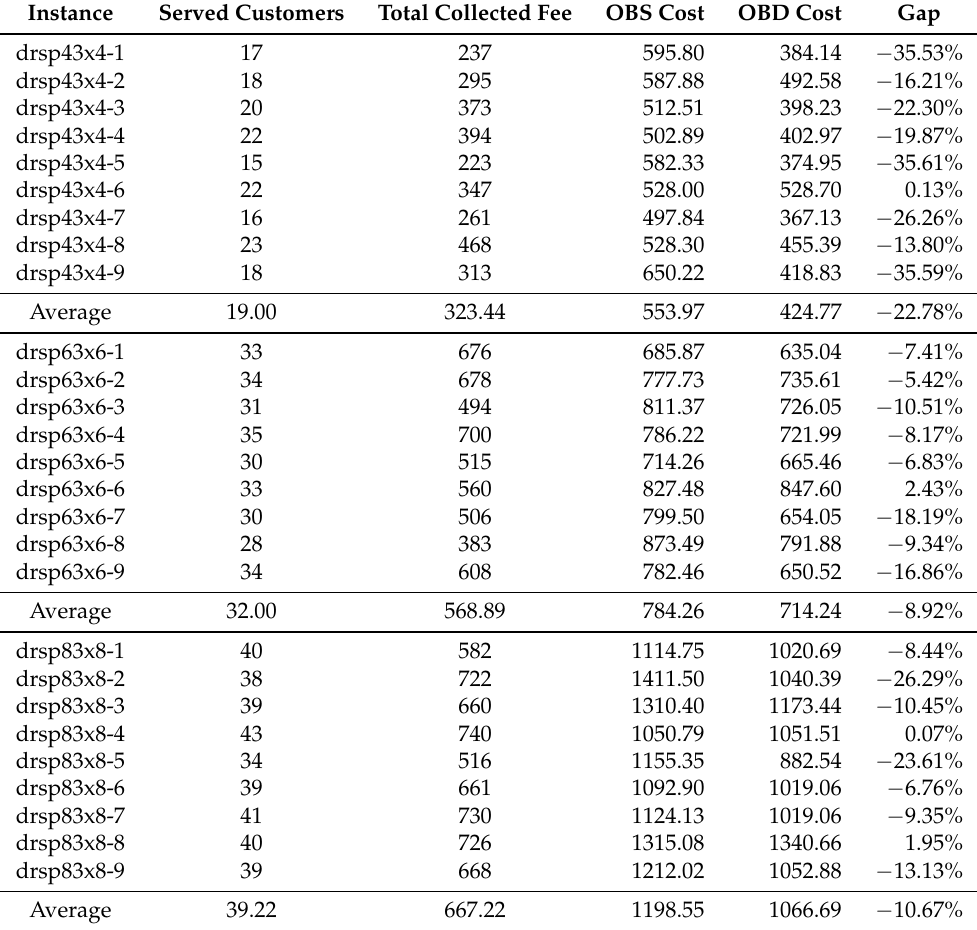
Table 5. Obtained results by our algorithm for a